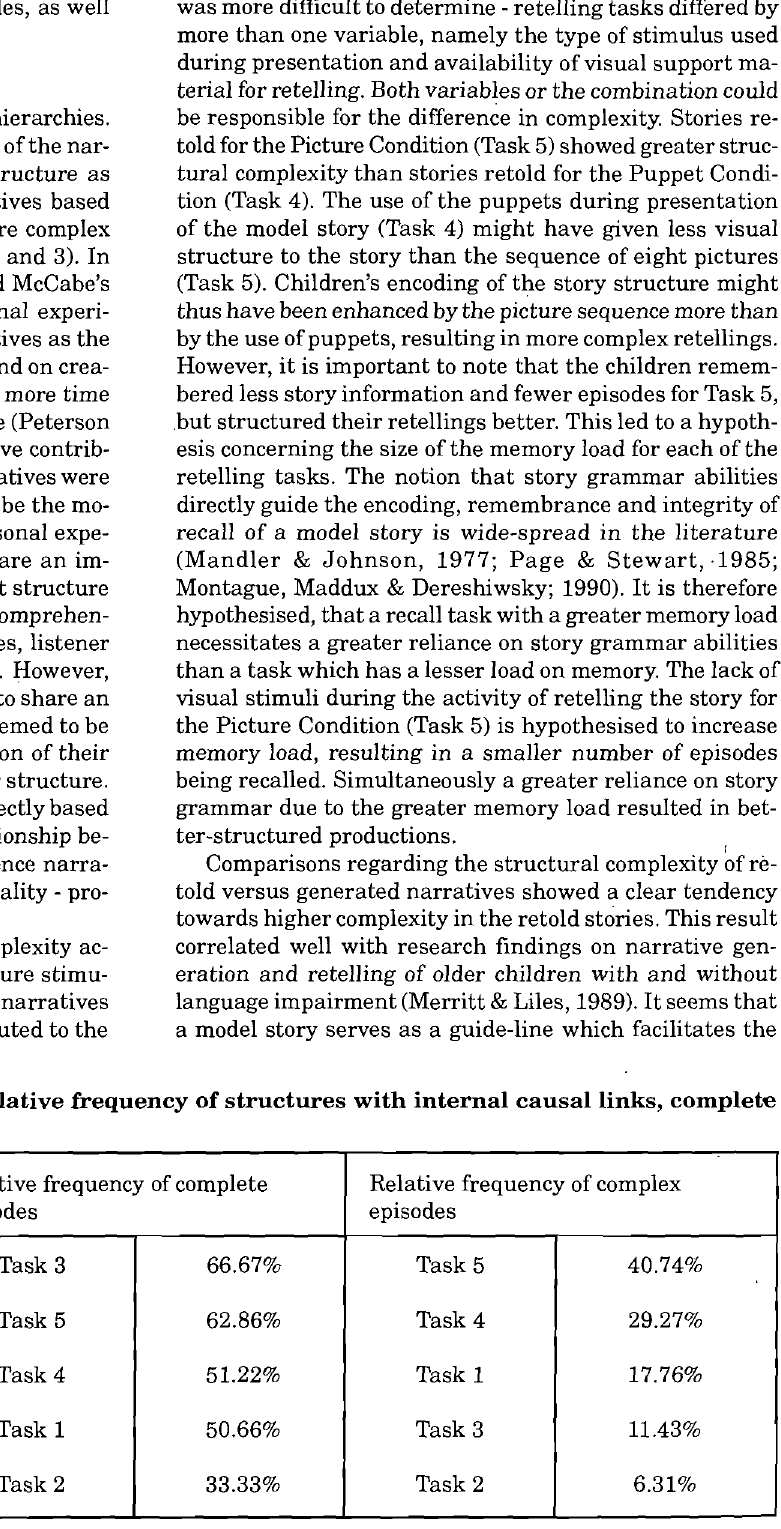
TABLE 2: Hierarchy of tasks regarding relative frequency of structures with internal causal links, complete episodes and complex episodes Relative frequency of